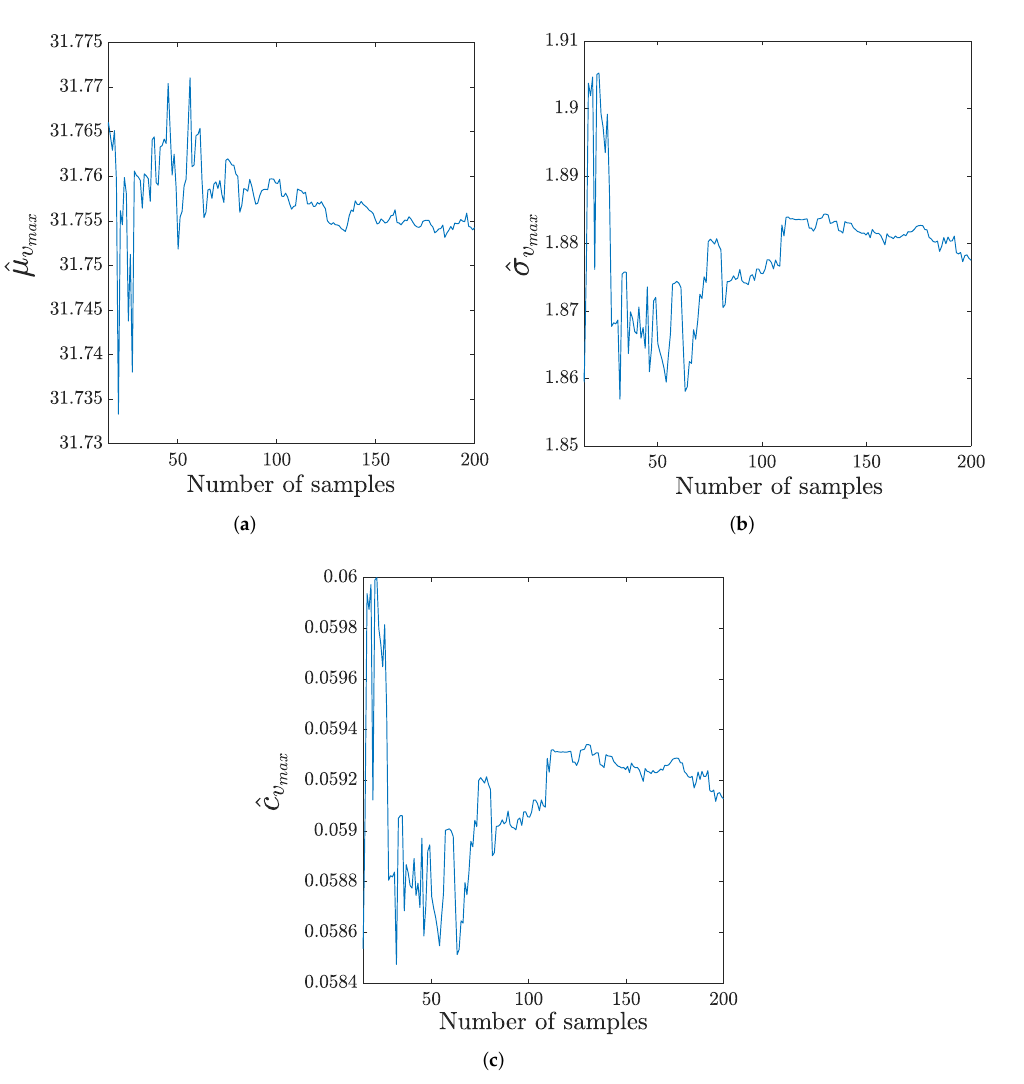
Figure 8. Convergence of PCE-based moments estimates of ( a ) mean, ( b ) standard deviation and ( c ) CV of QoI v max